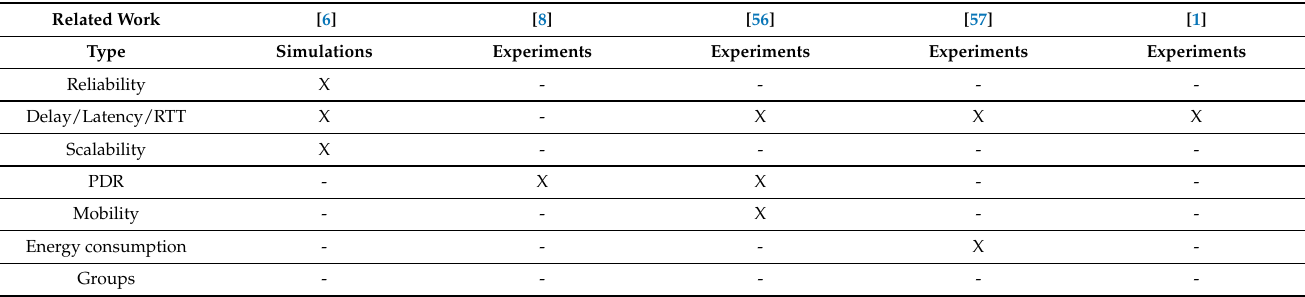
Table 4. BT Mesh evaluations in related